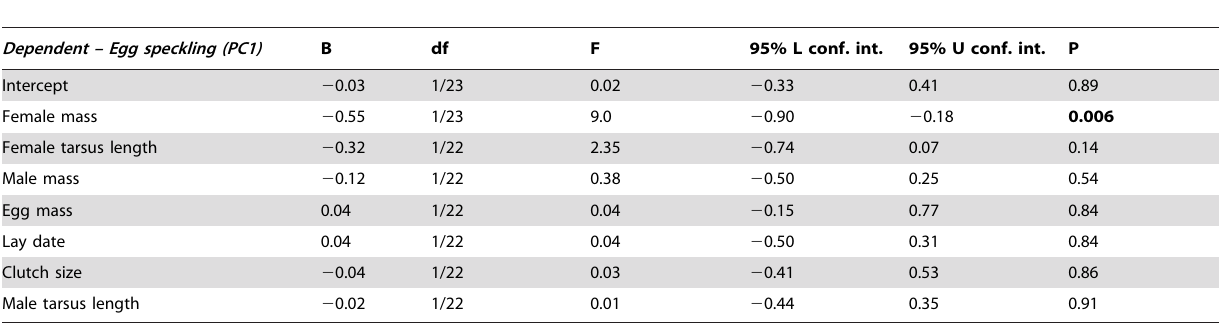
Table 5. General Linear Model showing that heavier females laid less speckled eggs (N=25